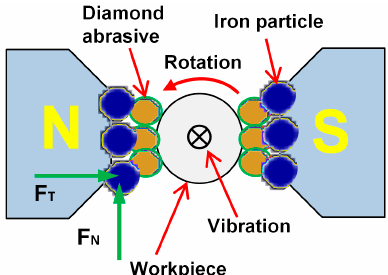
Figure 2. Schematic view of normal force ( F N ) and tangential force ( F T ) of magnetic force acting on abrasive tool.